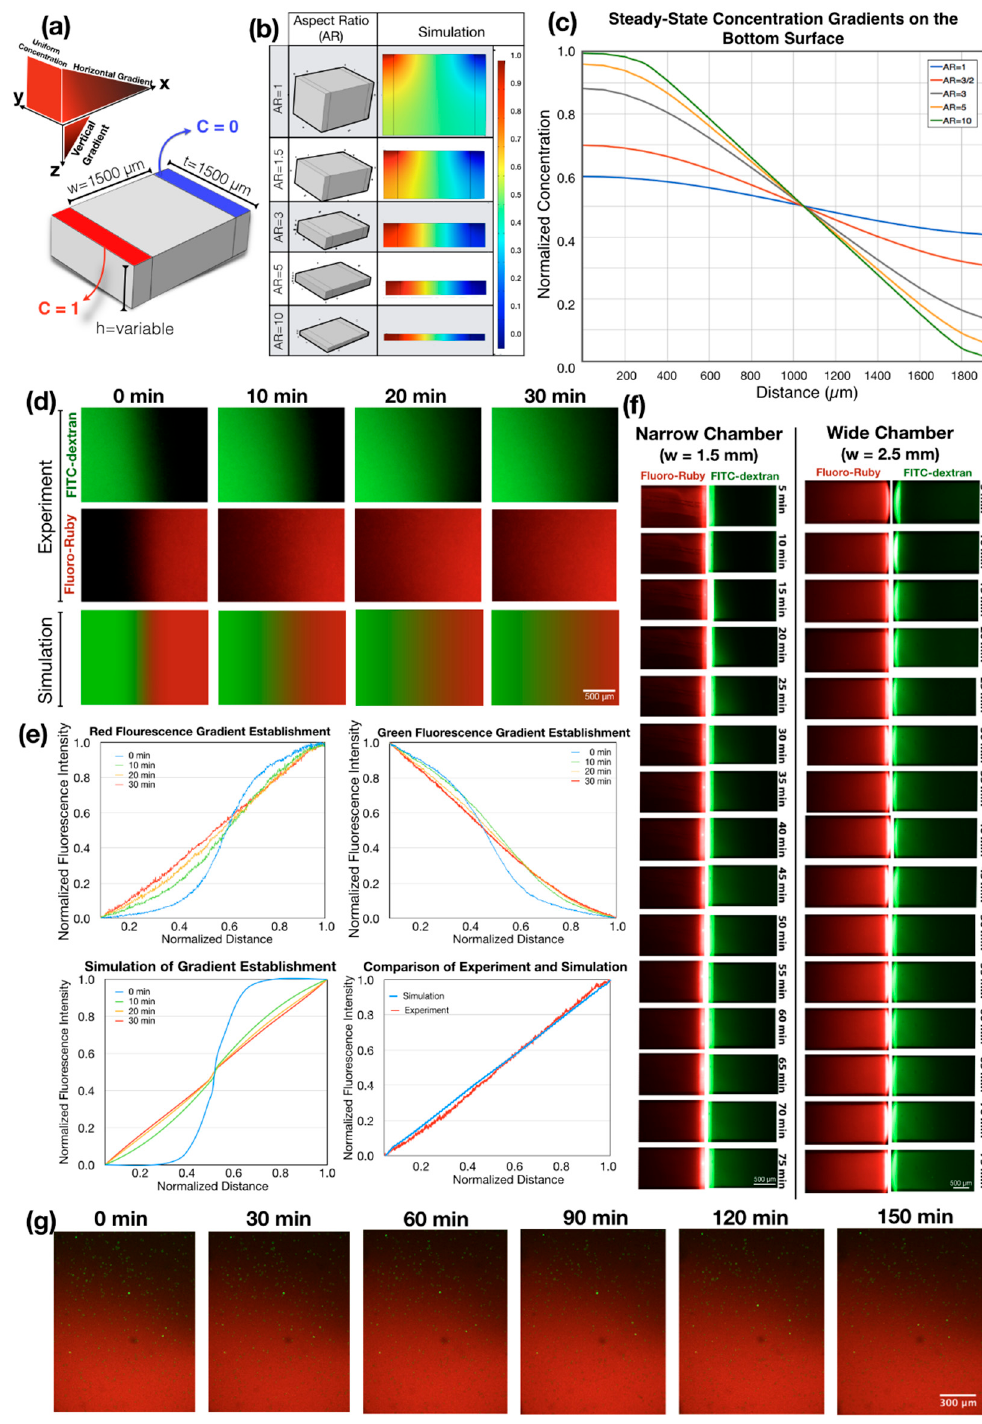
Figure 3. Generation of singular and dual competing concentration gradients in flow-free microfluidic chambers through coupled experimental and computational approaches. ( a ) A 3D model of gradient chamber with its dimensions and the boundary conditions used in simulations. ( b ) Results of simulations for controlling aspect ratios, which influences the gradients in the chambers. As the aspect ratio decreased, vertical concentration gradients began to dominate the system. ( c ) Concentration gradients measured at the bottom surface of the gradient chambers with controlled aspect ratios. As the aspect ratio decreased, the steepness of the gradients at the bottom surface of the gradient chamber decreased while maintaining the same average concentration. ( d ) Comparison of the experimental gradient generation and the simulation. The narrow gradient chamber was filled with FITC-Dextran (MW: 10,000) in half and Fluoro-Ruby (MW: 10,000) in the other half for faster generation